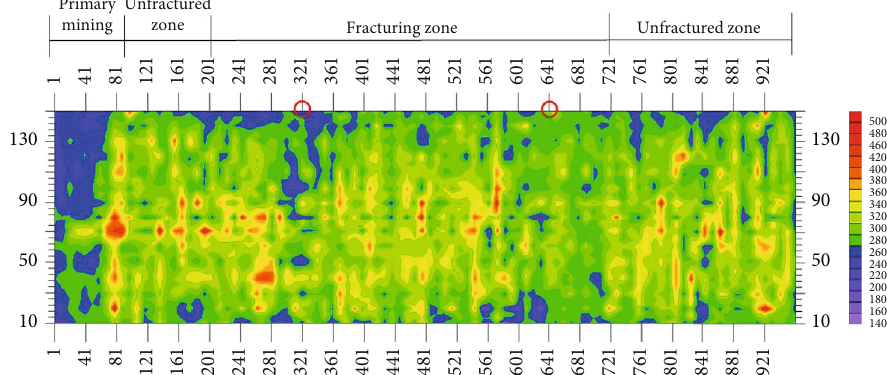
Figure 3: Plane characteristics of ore pressure changes. Table 3: Analysis of ore pressure evaluation